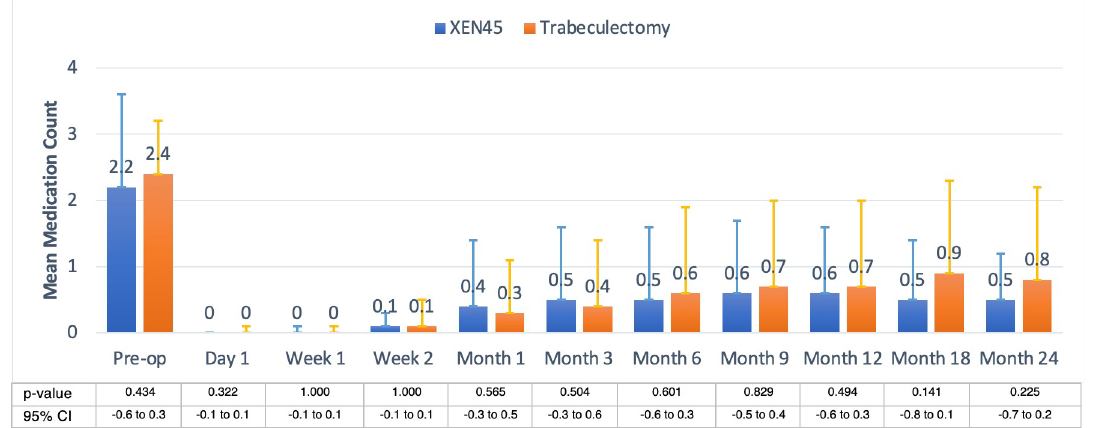
Fig 3. Mean number of medications between the XEN implant and trabeculectomy groups. Preoperative medications in XEN were comparable to trabeculectomy, at 2.2 versus 2.4. The postoperative numbers of medications were not different at any timepoint. The final numbers of medications were 0.5 in the XEN group and 0.8 in the trabeculectomy group.